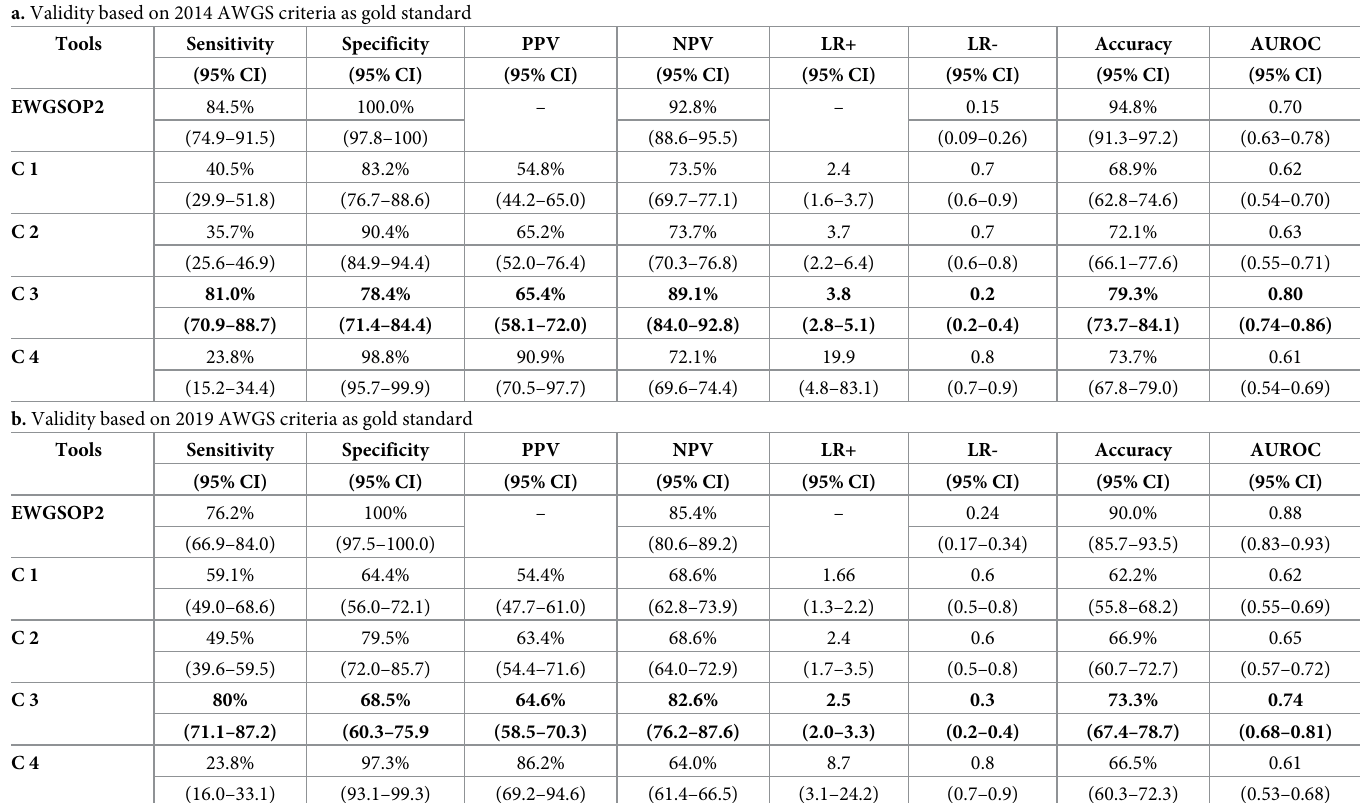
Table 4. Validity of combinations used to diagnose